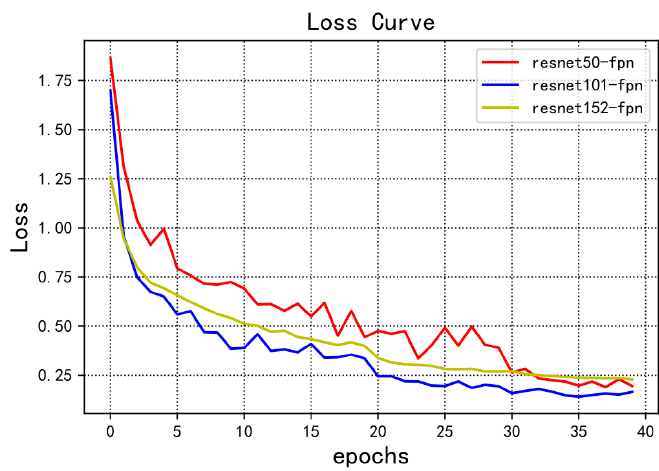
Figure 14. Loss curve of image segmentation training.